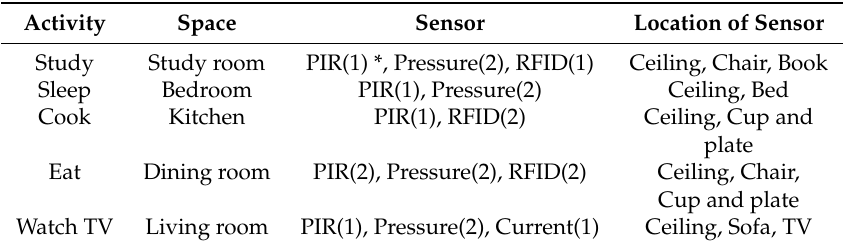
Table 1. Summary of distributed